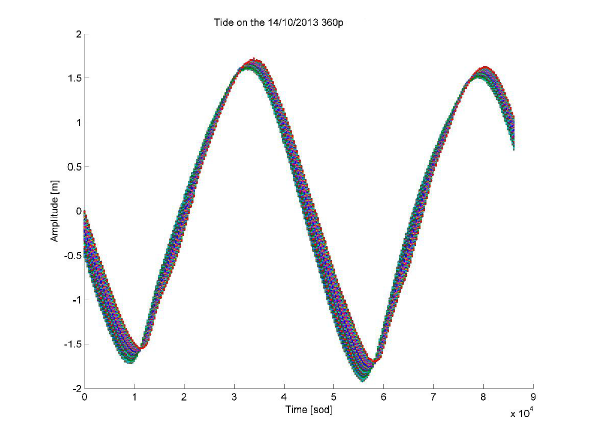
Figure 6: Calculated tide values in the grid points along the river segment using the alternative calculation